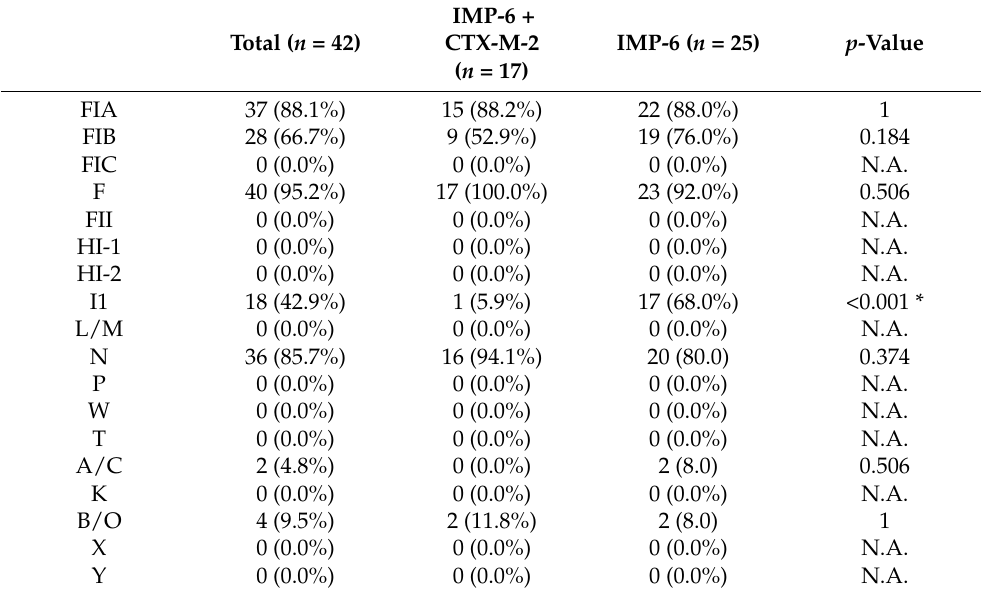
Table 3. Plasmid replicon typing among IMP-6-producing E. coli